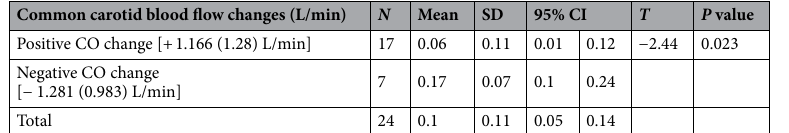
Common carotid blood flow changes (L/min) N Mean SD 95% CI T P value Positive CO change [+ 1.166 (1.28)